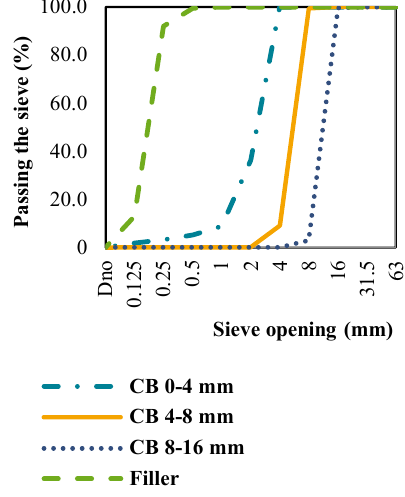
Figure 3. Grading curves of crushed bricks.